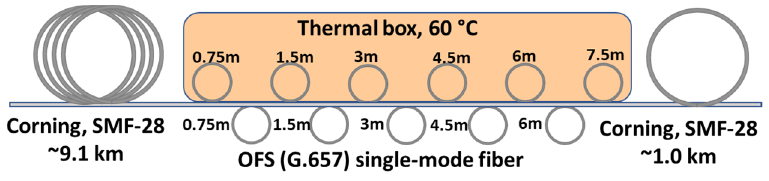
Figure 4. Optical fiber line for BOTDA testing.